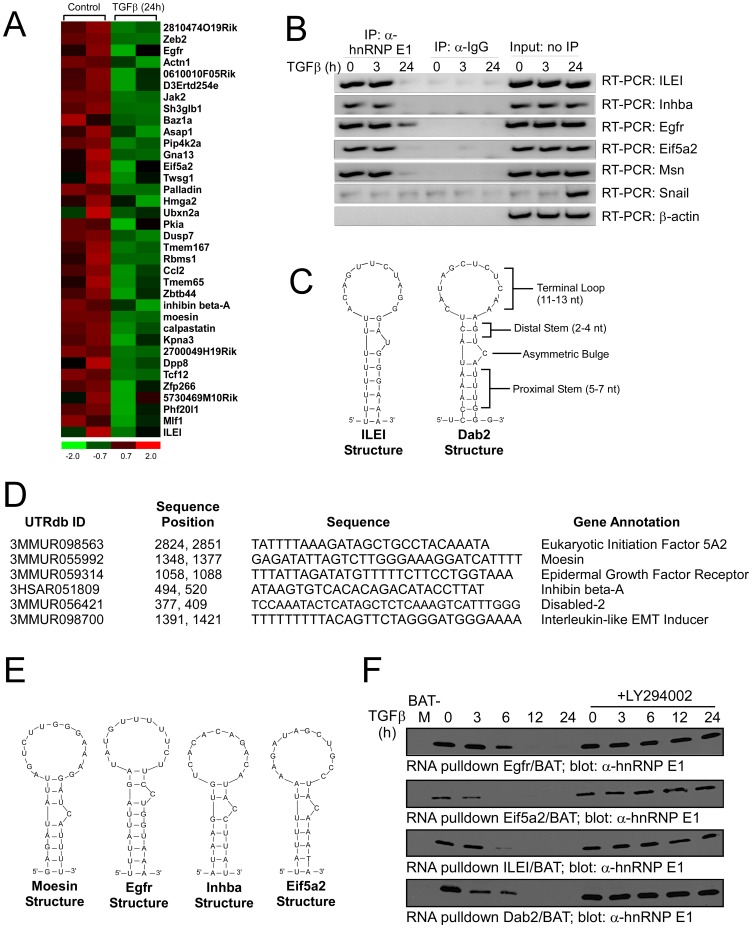
Identified mRNAs contain the BAT element and exhibit differential binding to hnRNP E1.(A) Heatmap of the RIP-Chip analysis for the putative EMT signature genes. (B) NMuMG cells were treated with TGFβ for times indicated, and RT-PCR was performed using gene specific primers for the potential targets, β-Actin (control) and Snail (EMT marker), on a RIP analysis. (C) Dab2/BAT and ILEI/BAT structures. Specific regions of the BAT element were selected and used to query the 3′-UTRs of the target mRNAs. (D and E) Secondary structures and sequences of target mRNAs with similarities to Dab2/BAT. (F) RNA affinity pull-down and immunoblot analyses to define the temporal association of hnRNP E1 with the selected BAT elements.